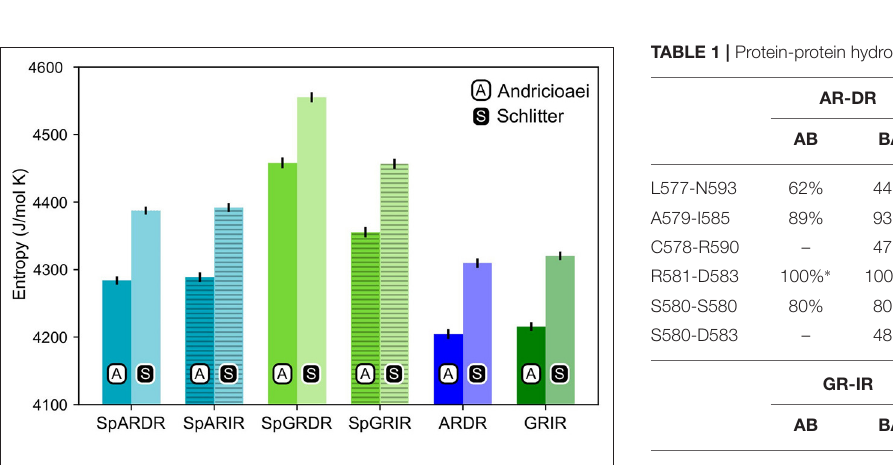
FIGURE 4 | Entropy estimates for the proteins of all complexes. The first and second columns, shown with black A and white S are the entropy values estimated with the Andricioaei and Schlitter models, respectively.